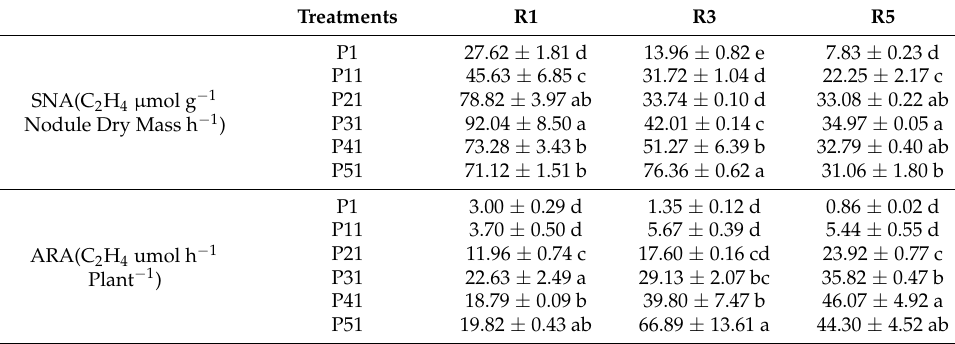
Table 2. Effects of different phosphorus supply levels on soybean SNA and